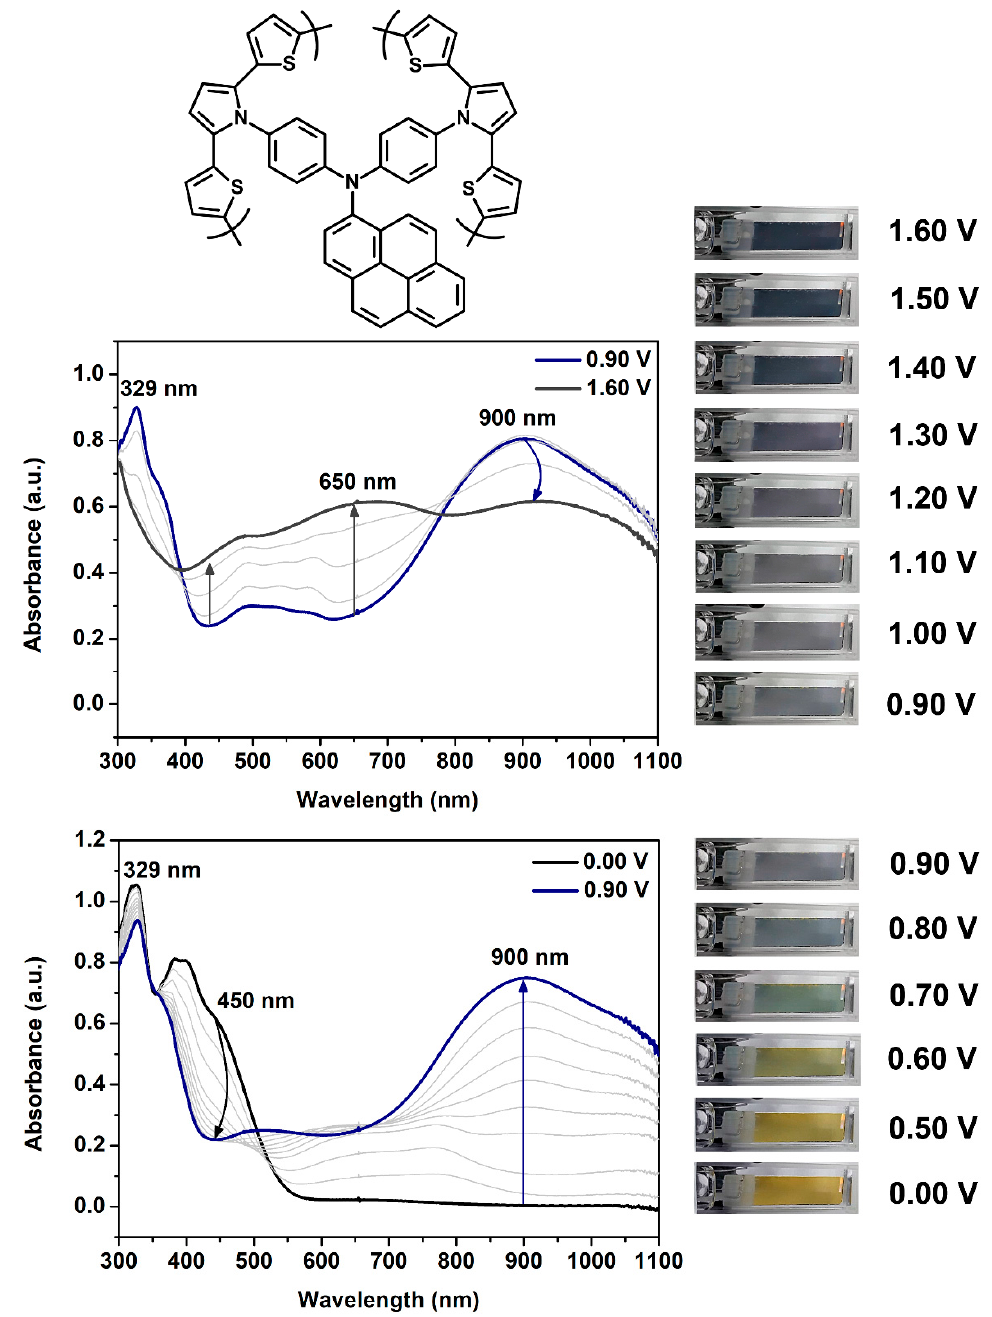
Figure 11. Spectroelectrograms and color changes of P2 thin films on ITO-coated glass in 0.1 M Bu 4 NClO 4 / MeCN at various applied voltages.